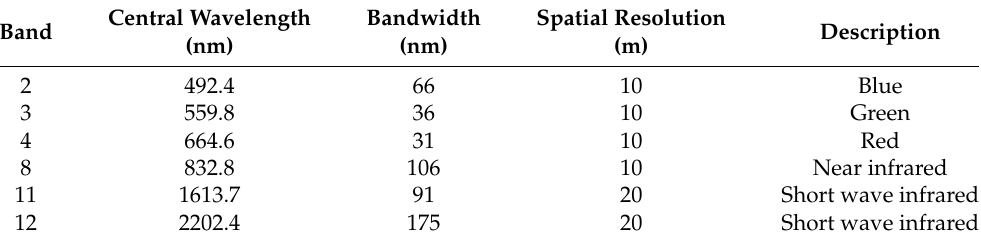
Table 2. The partial band information on Sentinel-2A.